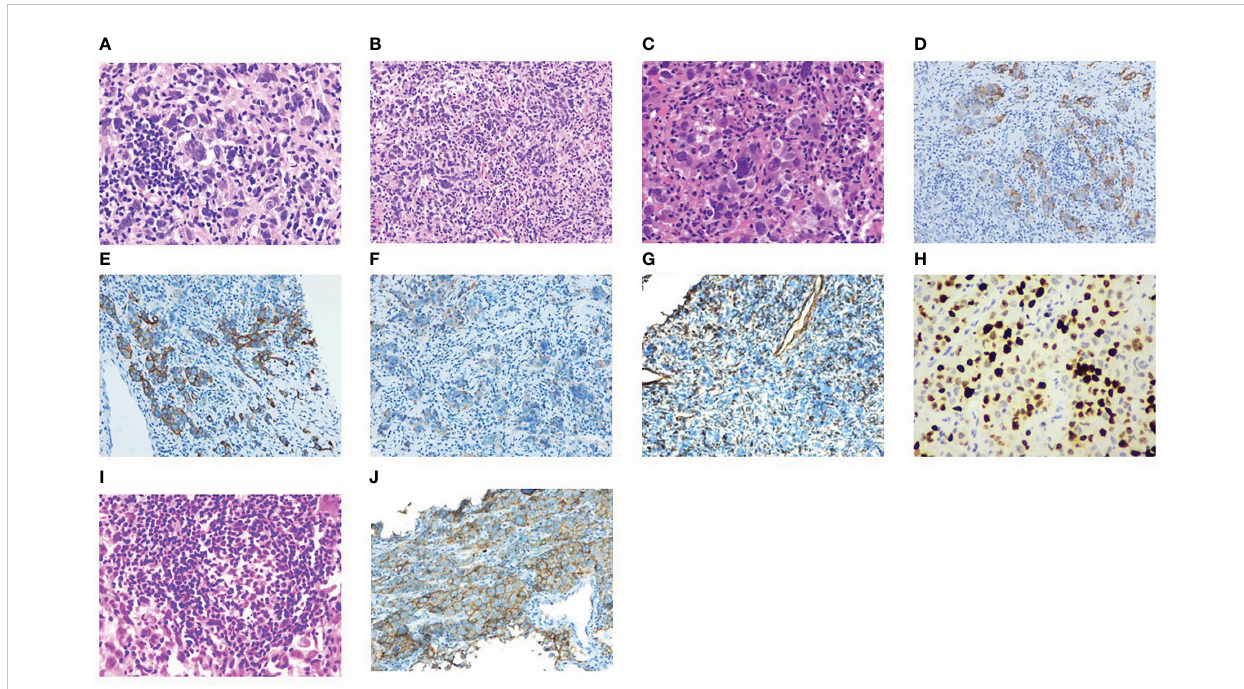
FIGURE 2 Pathological results. (A – C) Structural destruction in lymphoid tissue, diffuse hyperplasia of heteromorphic tumor cells, large size of tumor cells, obvious pleomorphism, spindle-shaped and polygonal, large and deep stained nuclei and irregular pseudoinclusion bodies in nuclei, multinucleated and giant tumor cells in some tumor cells, multiple nucleoli, mitotic images are easy to see (magni fi cation × 40, 20, 40). (D – H) IHC staining showed sequentially CKpan, CAM5.2, EMA, Vimentin, Ki67 (+). (I) Localized aggregation of lymphocytes to form nodules, and the formation of a central germinal center of the nodule is seen, consistent with tertiary lymphoid structures. (J) Positive for PD-L1